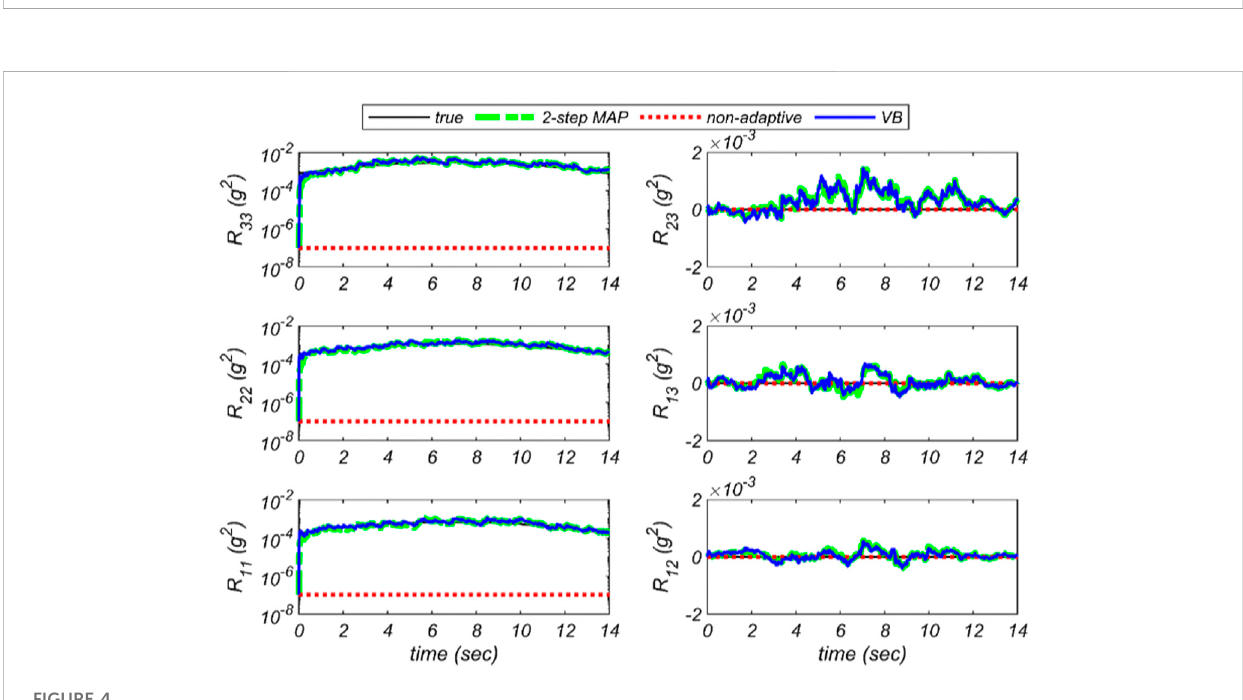
FIGURE 4 Comparison of the estimated components of the covariance matrix of measurement noise by the three methods (VB, two-step marginal MAP, and the non-adaptive) with the true ones. It should be noted that R (cid:2)